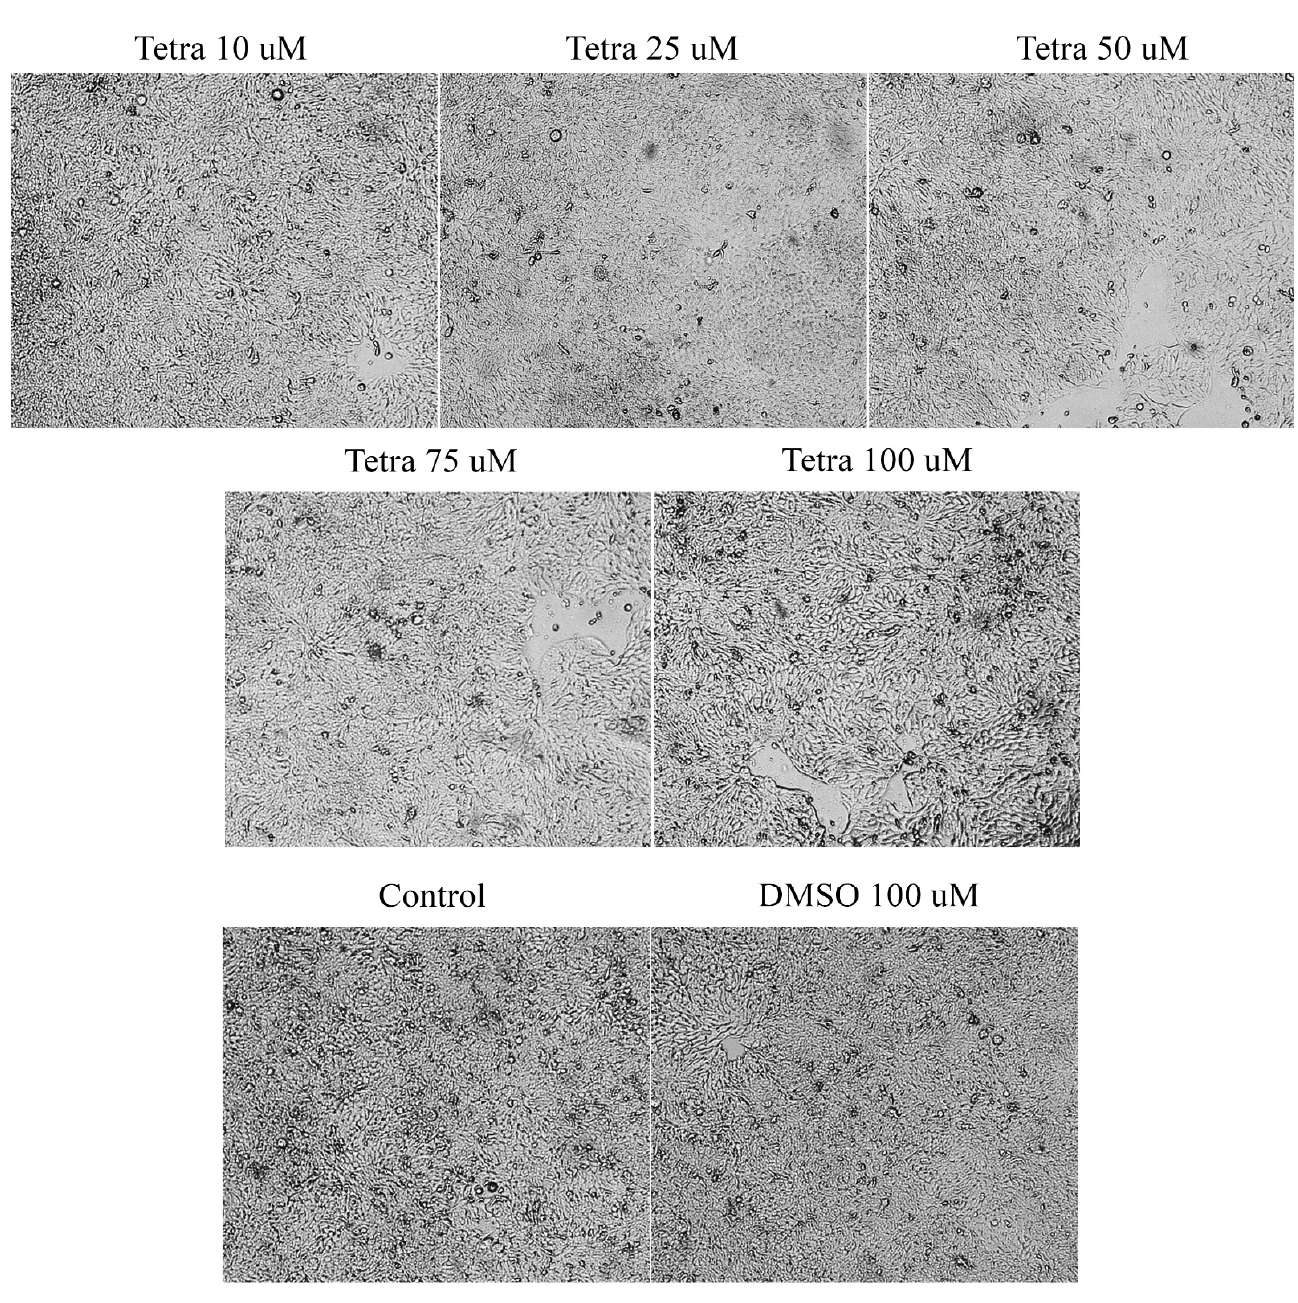
Figure 3. Morphological and shape changes produced by tetracycline treatment in HT-29 after 72 h of treatment. 20× magnification.